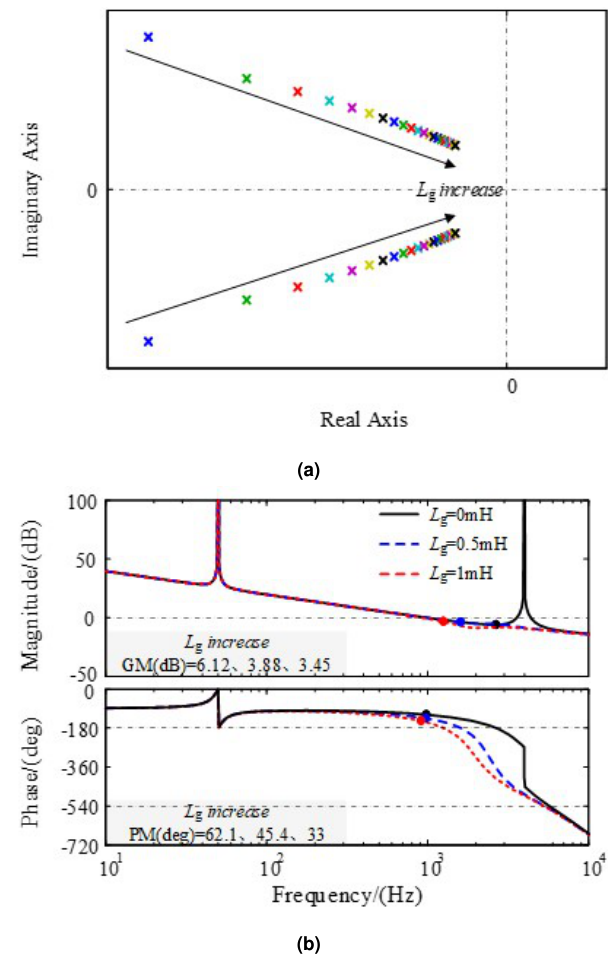
Fig. 17. System Stability Analysis Corresponding to i WAC ( s ) . (a) Bode diagram of open loop transfer function T WACl ( s ) . (b) i WAC ( s ) corresponds to the system closed-loop dominant pole root